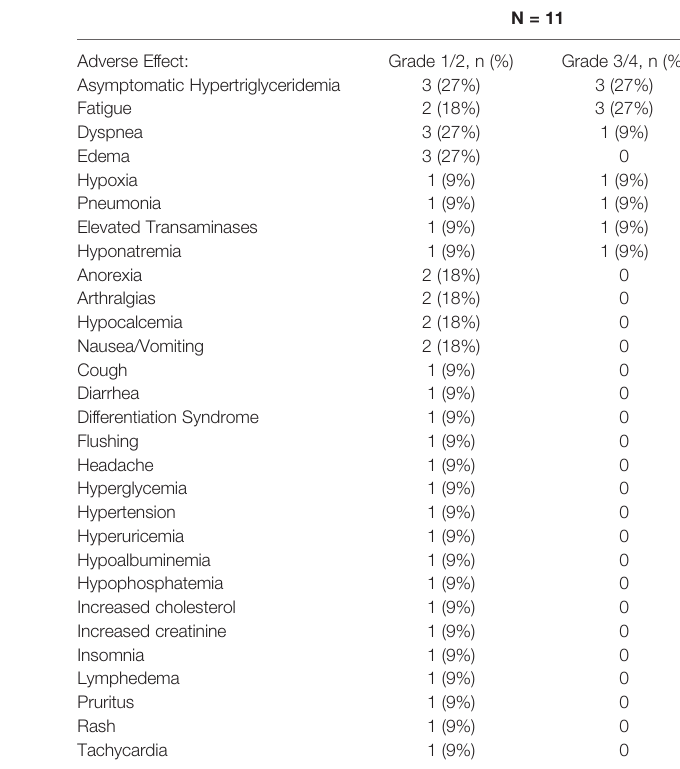
TABLE 2 | Treatment emergent adverse events possibly related to